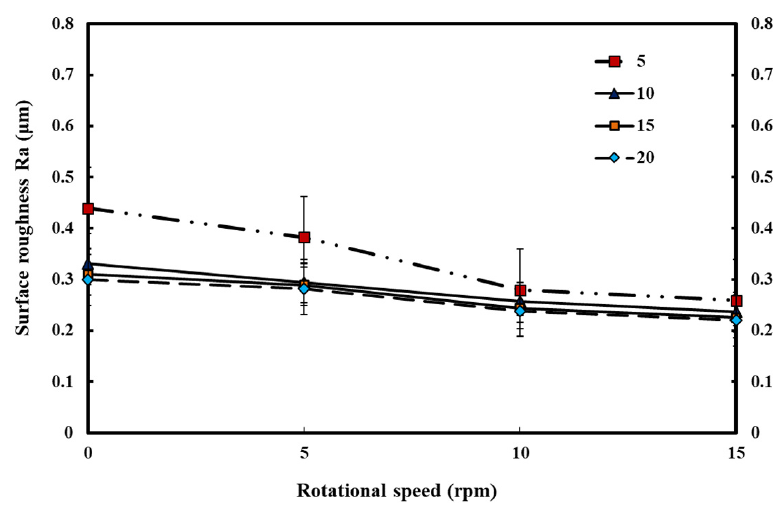
Figure 9. Effects of the reciprocating cycles on surface roughness.